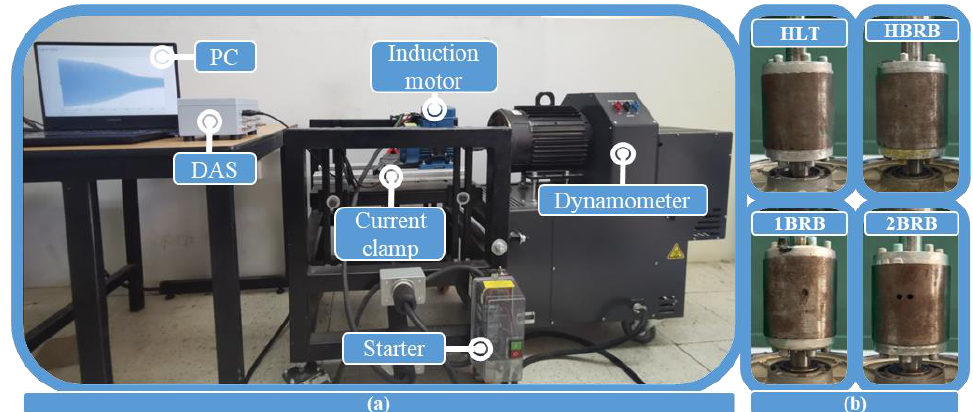
Figure 9. ( a ) Experimental setup and ( b ) Rotor conditions.